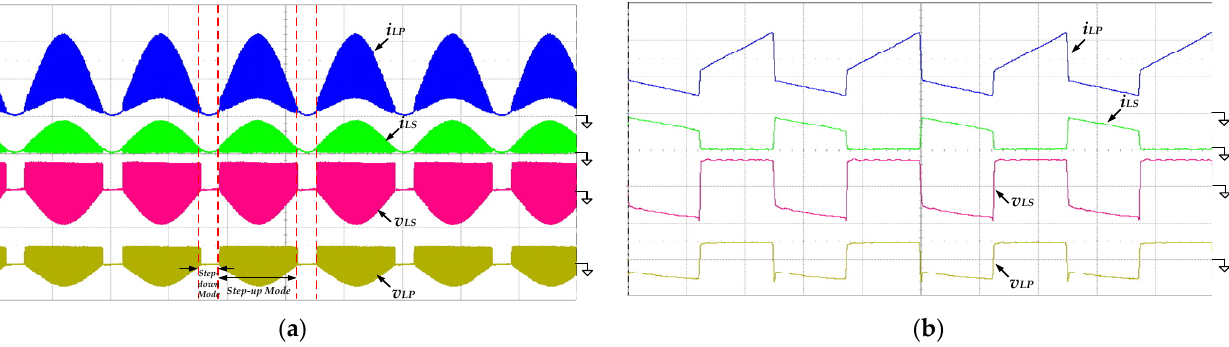
Figure 13. The measured waveforms of the inductor currents i LP , i LS and the inductor voltages v LP and v LS at 100 V input voltage, 500 W output load and ( a ) low-frequency line cycle ( v LP , v LS : 200 V/div; i LP , i LS : 10 A/div; time: 5 ms/div); ( b ) high-frequency switching cycle ( v LP , v LS : 200 V/div; i LP , i LS : 10 A/div; time: 20 μ s/div).